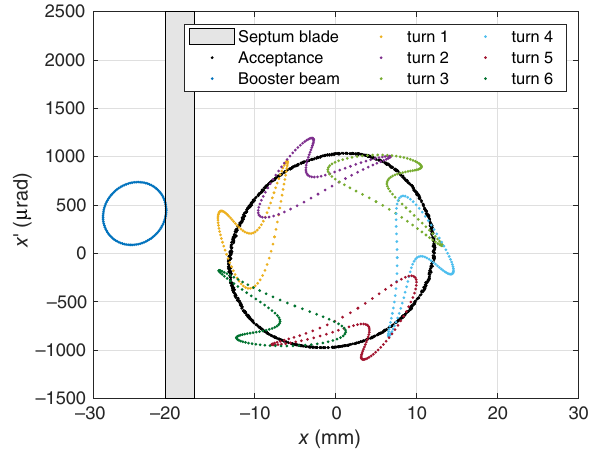
FIG. 5. Simulated MIK injection: at the injection point, the booster beam (100 blue dots 3 σ envelope) is injected close to the septum blade (shaded area) outer face and captured within the dynamic aperture (black dots) after the MIK kick. Because of its size, the injected beam (multicolor) exhibits the footprint of the MIK field during the first turns (six represented).